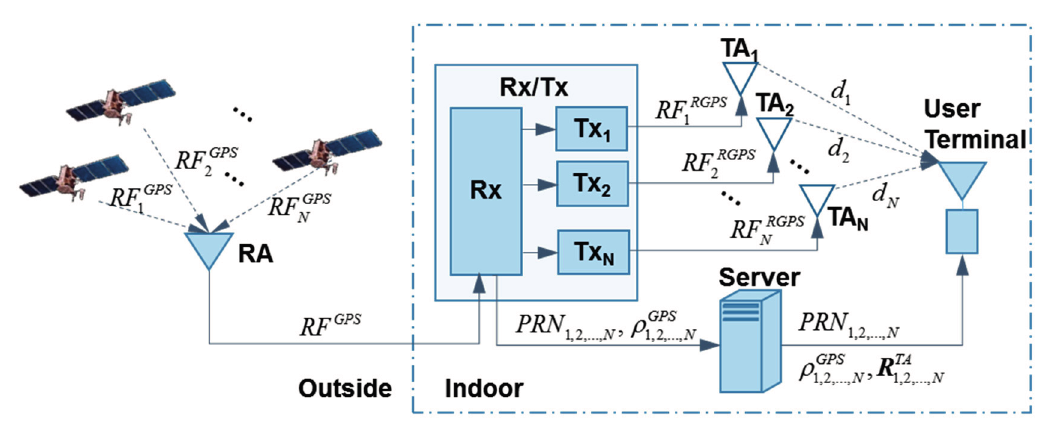
Figure 1. Indoor positioning